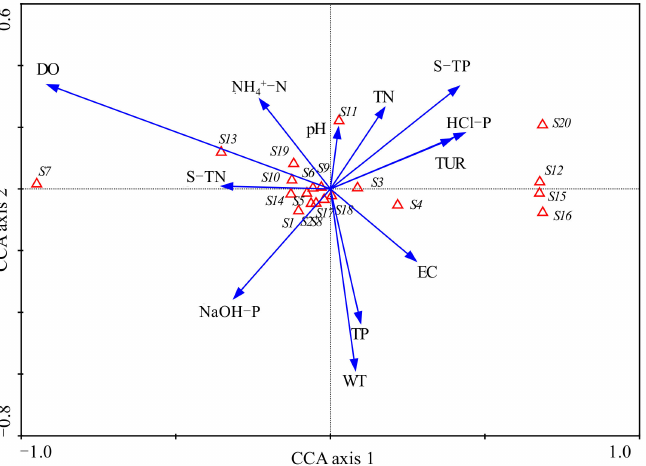
Figure 10. Results of CCA plotted for axis 1 and axis 2. Sediment microbial phyla are represented by an open triangle and the explanations for the symbols used are given in Table 3. Environmental factors are expressed as blue lines with arrows. S-TN: sediment total nitrogen, S-TP: sediment total